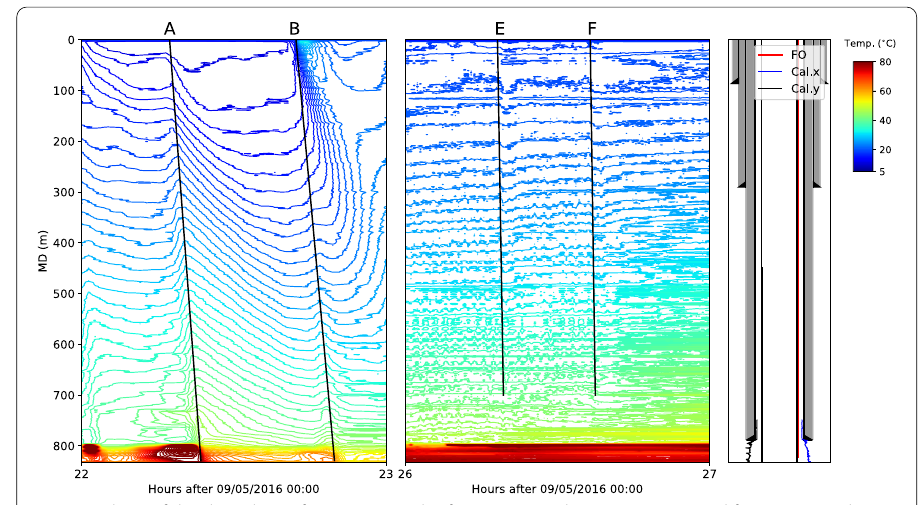
Fig. 7 Picking of droplet velocity from contour plot for event A and event B (water) and for event E and event F (cement)